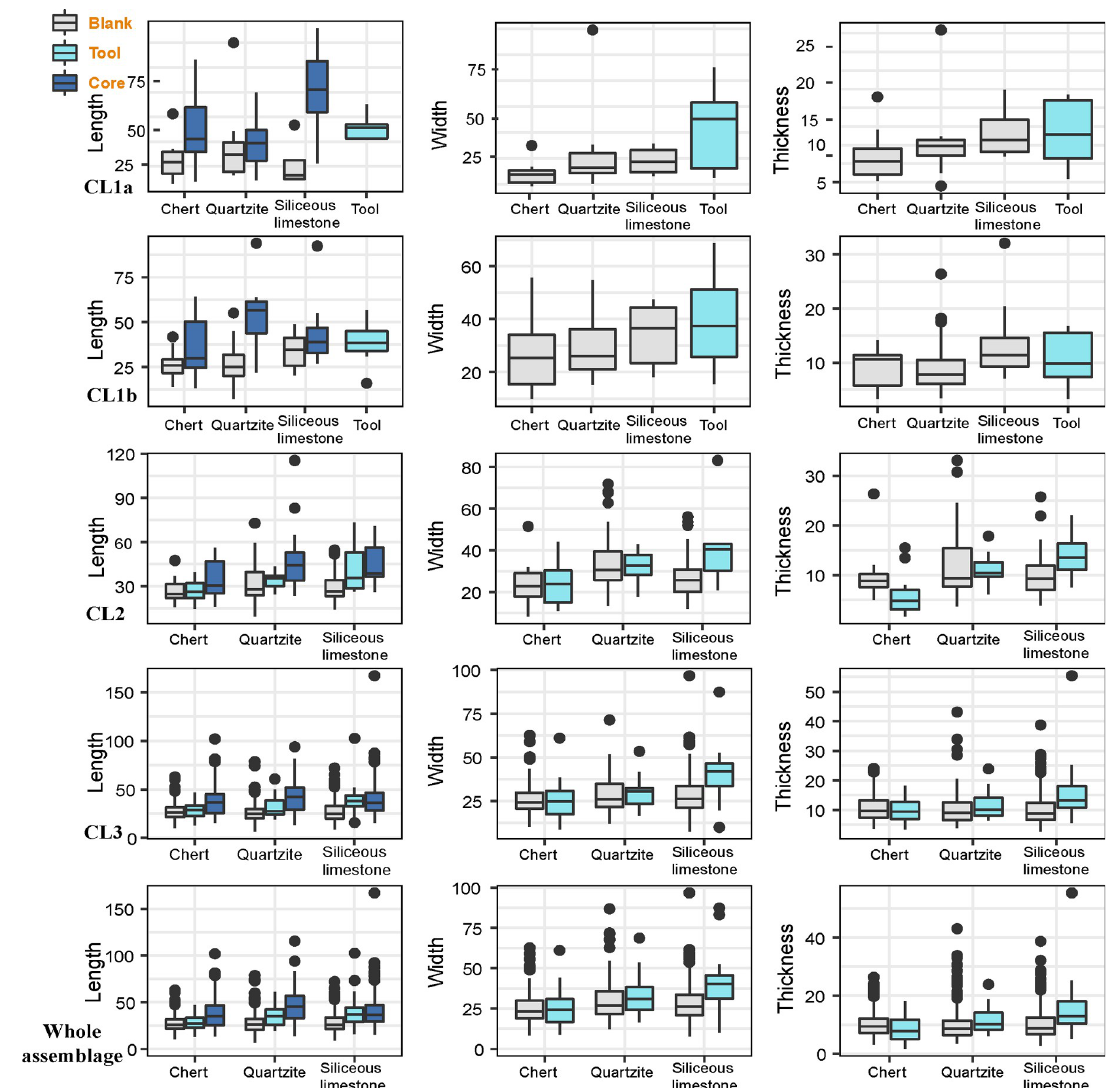
Fig 10. Size of flakes and tools of three raw materials. The length, width, and thickness of blanks (grey), tools (light blue), and cores (dark blue); In CL1b and CL1b, due to small sample size, all tools were grouped together regardless of raw